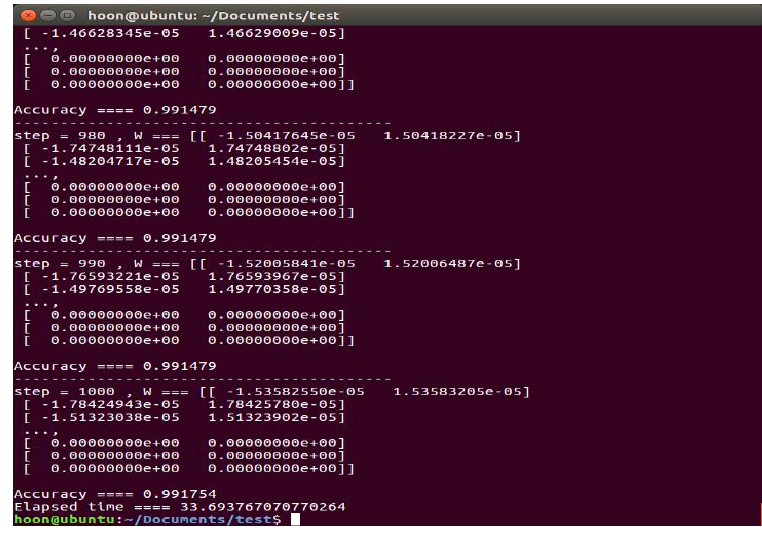
Figure 10. Small learning rate.